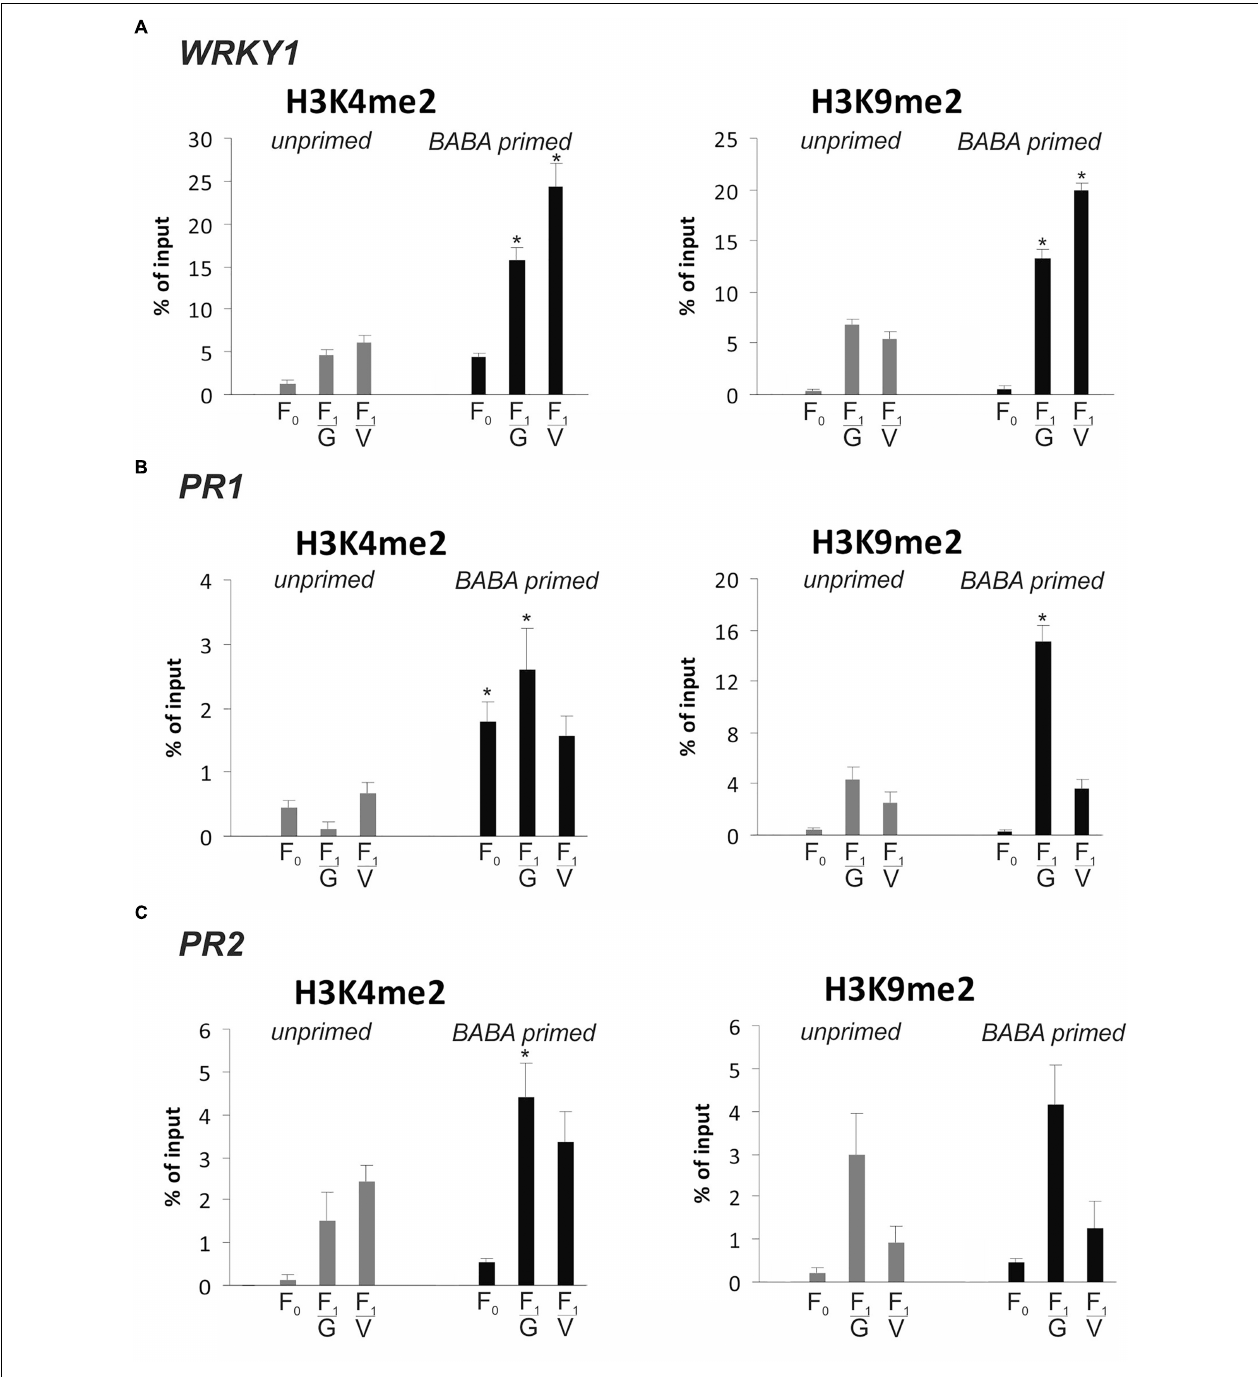
FIGURE 7 | Epigenetic marks on SA-dependent genes in response to BABA-priming. Distribution levels of H3K4me2 and H3K9me3 on the gene body region of WRKY1 (A) , PR1 (B) and PR2 (C) at the stage before the second challenge. ChIP-qPCR analyses were performed after 5 mM BABA (BABA-primed) or water treatment (unprimed), in the parental line (F 0 ) and its descendants (F 1 ) derived from tubers (F 1 / V ) or seeds (F 1 / G ). Each experiment was repeated three times and the data are presented as percentages of input DNA. Asterisks indicate values that differ significantly from unprimed (water treated) potato leaves at P < 0.05 ( ∗